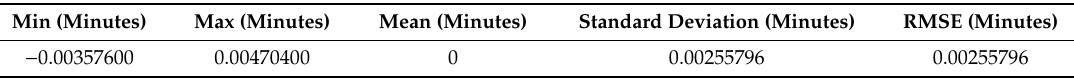
Table 9. Statistical values of the residuals for the longitude coordinates resulting from datum transformation OSPM / ED50 to OSPM / WGS84 based on a simplified approach (translation).